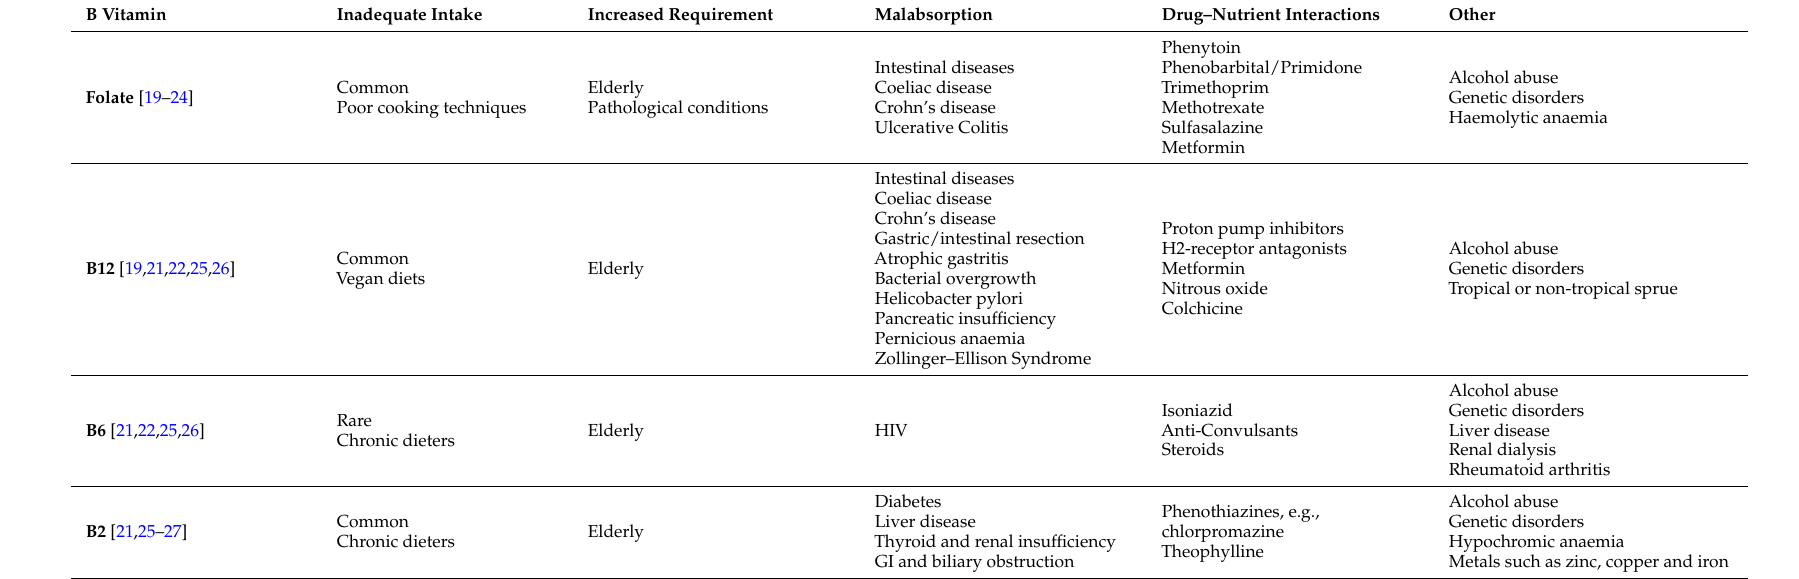
Table 1. Causes of B vitamin